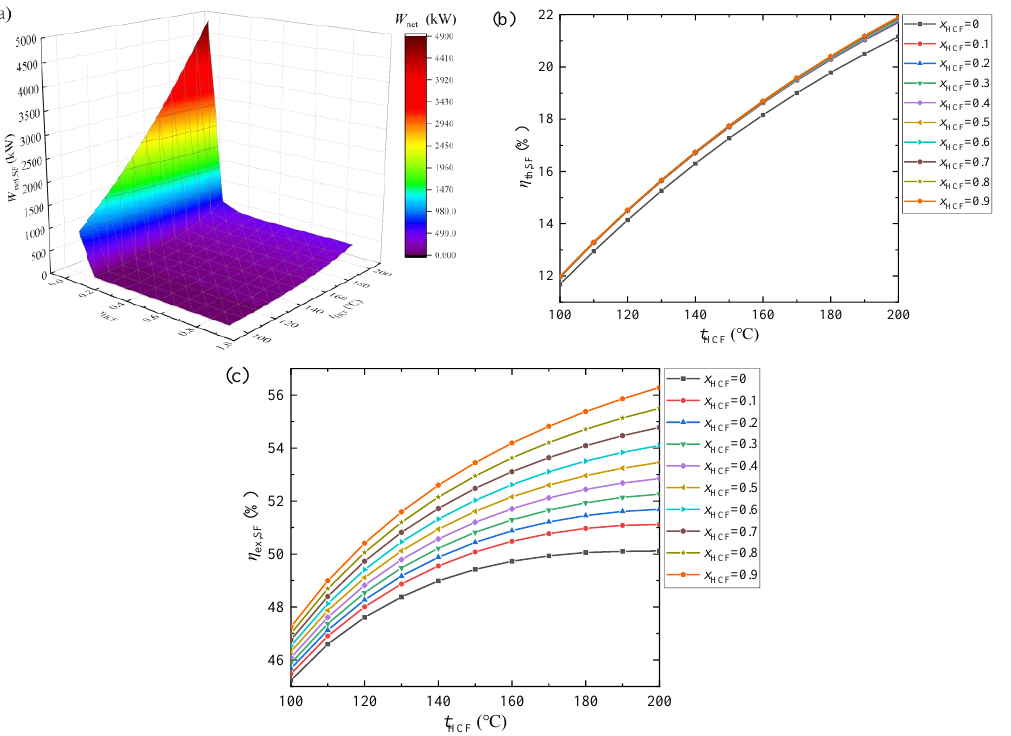
Figure 16. Variation of optimal thermodynamic parameters of the SF system with steam quality at different heat carrier temperatures: ( a ) W net, SF , ( b ) η th, SF and ( c ) η ex, SF.